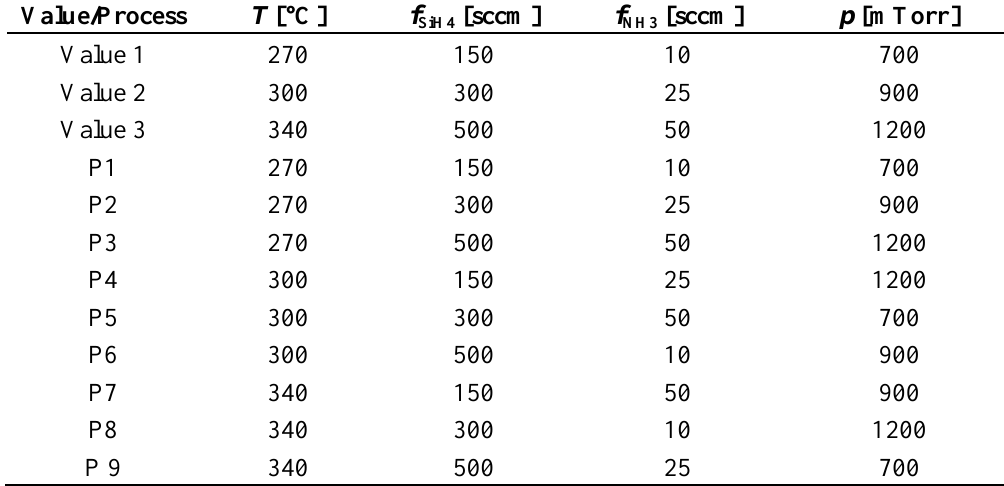
Table 1. Values of RF PECVD process parameters determined according to Taguchi’s orthogonal tables approach. Process time and power applied to the reactive chamber were constant during all the runs and reached 5 min and 50 W,